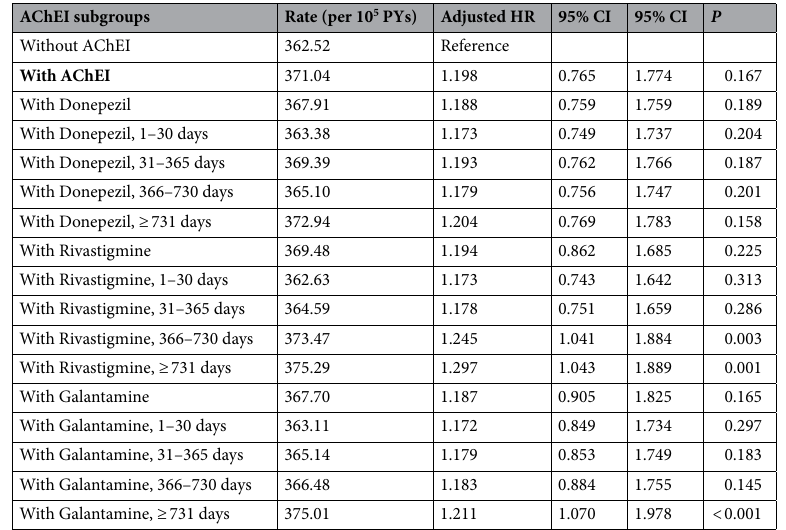
Table 3. Factors of lung cancers among AChEI subgroups by using Cox regression and Fine and Gray’s competing risk model. PYs person-years, Adjusted HR adjusted hazard ratio: adjusted for the variables listed in Table 3, CI confidence